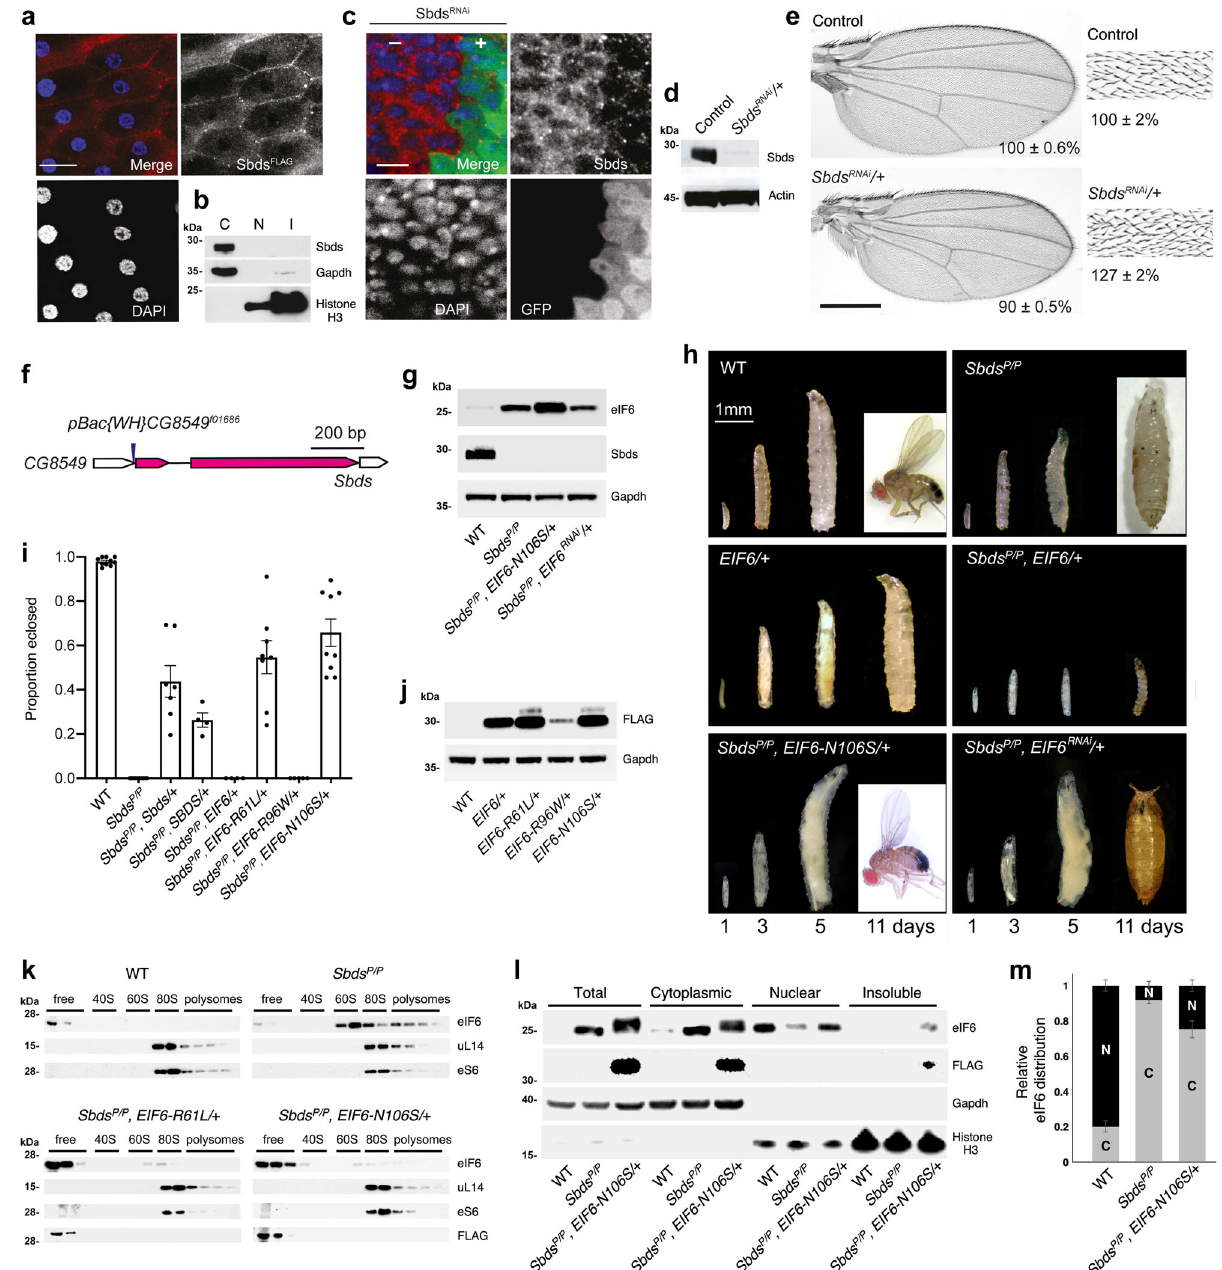
Fig. 7 eIF6 missense mutations fully rescue the larval lethality of Sbds-de fi cient D. melanogaster . a – c Cytoplasmic localization of Drosophila Sbds by ( a ) immunostaining of FLAG-tagged Sbds (red) in ovarian follicle cells, the nucleus in blue (DAPI), scale bar: 10 μ m, 3 replicates, n = 30; ( b ) immunoblotting of third instar Drosophila larval cytoplasmic (C), soluble nuclear (N) and insoluble nuclear (I) fractions (3 replicates); ( c ) indirect immuno fl uorescence of the third instar larval wing disc cells. Sbds (red) depleted by RNAi in posterior wing disc cells (marked with GFP); the nucleus is blue (DAPI), scale bar: 10 μ m, 3 replicates, n = 30. d RNAi depletion of Sbds in third instar larval extracts revealed by immunoblotting (3 replicates). e Sbds is required for cellular growth. RNAi depletion of Sbds in developing wings versus control. Wing size ( n = 15, p-value <0.0001, left) and bristle density ( n = 10, p-value <0.0001, right) as a percentage (±s.e.) of control. Scale bar: 200 μ m. A two-tailed student t -test was used. f Drosophila Sbds (CG8549) locus. PiggyBac-element insertion site (arrow) and Sbds coding region (magenta) are shown. g Indicated proteins revealed by immunoblotting of larval extracts from indicated genotypes (3 replicates). h eIF6-N106S mutation or eIF6 dose reduction rescues larval lethality of Sbds -de fi cient fl ies. Development at indicated time-points after egg laying is shown. Scale bar: 1 mm. i Genetic complementation of homozygous Sbds P/P mutant fl ies (at least 4 replicates, minimum n = 156; error bars represent mean ± s.e). j SDS-related eIF6 mutant protein expression in WT larvae expressing eIF6 WT or missense mutants (3 replicates). k eIF6 - N106S and R61L variants have lower af fi nity for the 60 S subunit. Larval extracts were fractionated by sucrose gradient sedimentation and proteins visualized by immunoblotting (3 replicates). l EIF6-N106S rescues the cytoplasmic redistribution of eIF6 in Sbds-de fi cient fl ies. Subcellular fractions of third instar larvae cells with the denoted genotypes were immunoblotted to visualize the indicated proteins (3 replicates). m Subcellular distribution of endogenous eIF6 in the denoted genotypes quanti fi ed by densitometry of ( l ). Error bars represent mean ± s.e.; 3 replicates. Drosophila strains and genotypes are listed in Supplementary Tables S2a,